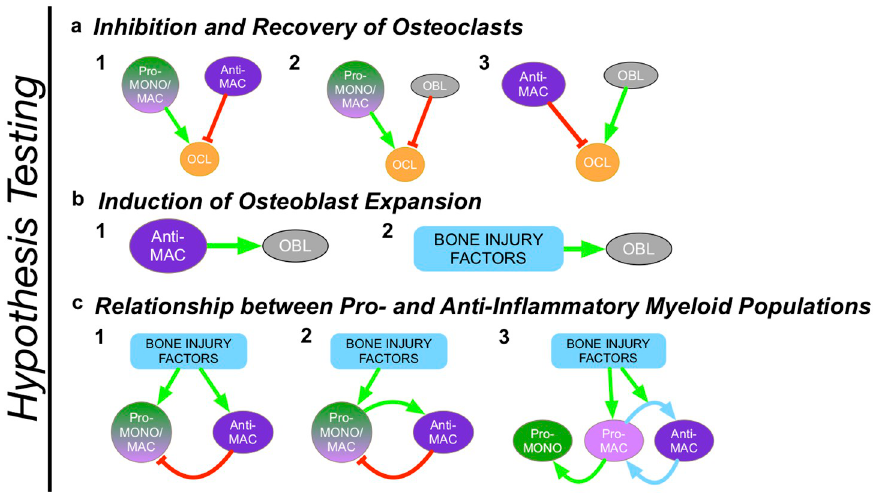
Fig 2. Comprehensive combinatorial modeling pipeline is built to identify relevant myeloid behaviors necessary to recapitulate in vivo bone injury repair data. Literature curation reveals sets of well-established competing biological mechanisms potentially governing modulation of osteoclast formation ( a ), regulation of osteoblast formation ( b ), and relationships between pro- and anti-inflammatory myeloid cells ( c ). Model adopts all combinations of hypotheses regarding these mechanisms to recapitulate in vivo data. Comparing model fits resulting from each hypothesis combination reveals best-fitting